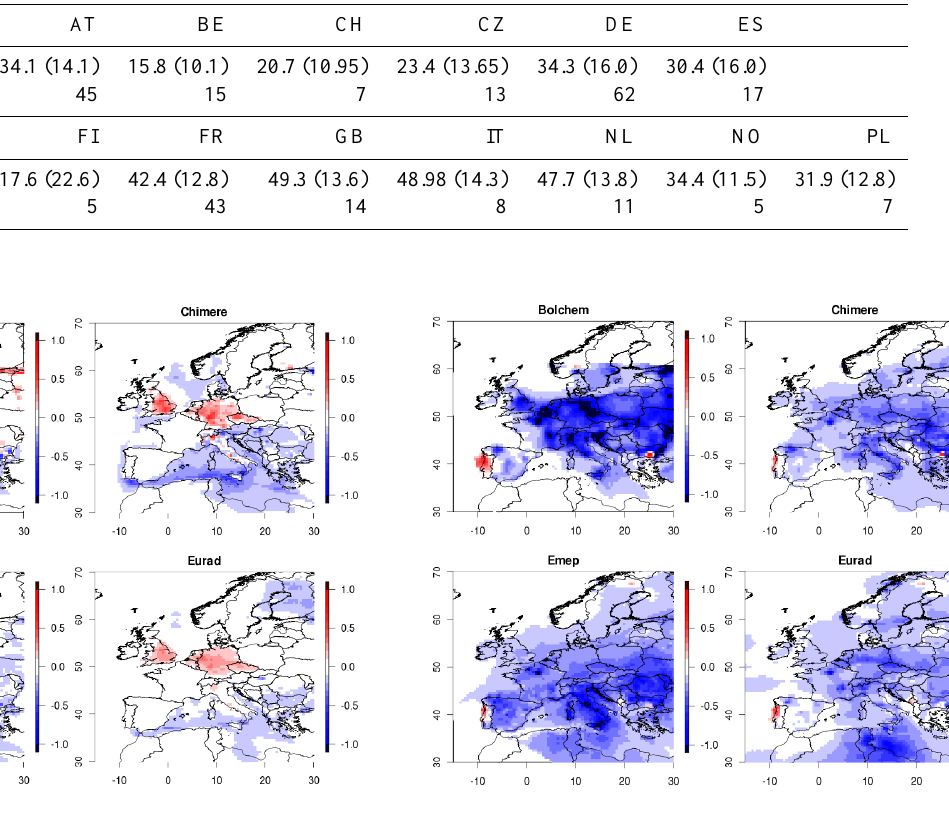
Figure 16 : Same as Figure 14 for PM10. Fig. 16. Same as Fig. 14 for PM 10 . study involving global models. Downwards trends of NO 2 were successfully captured at 73 % of the stations on